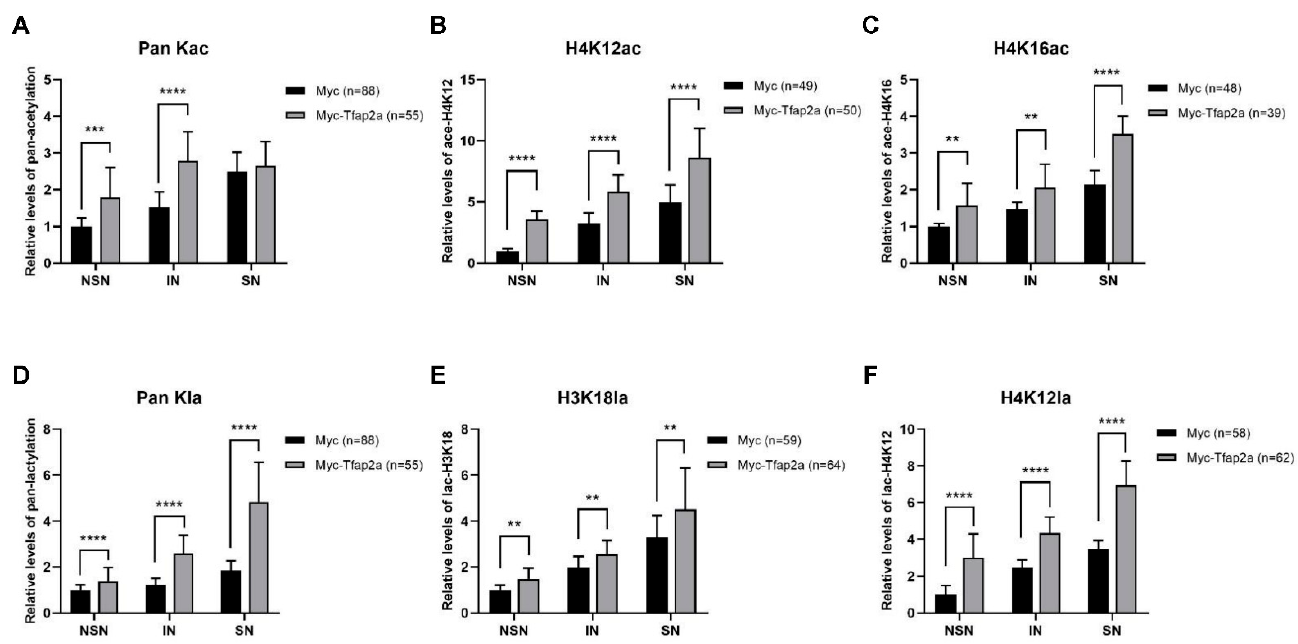
Figure 8. Quantification of fluorescence intensities of histone acetylation and lactylation at different phases in mouse GV oocytes after the overexpression of Myc and Myc-Tfap2a shown in Figure 7. The fluorescence intensities of pan histone acetylation ( A ), H4K12ac ( B ), H4K16ac ( C ), pan histone lactylation ( D ), H3K18la ( E ), and H4K12la ( F ) were quantified based on immunofluorescence staining. The average relative fluorescence intensity of the NSN oocytes from the Myc group was set to 1. The data are expressed as the mean ± SEM of at least three independent experiments. ** p < 0.01, *** p < 0.001, **** p < 0.0001.